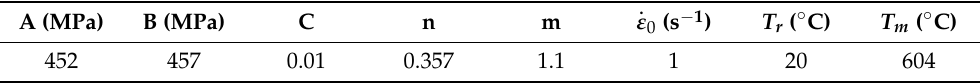
Table 3. Material constants for Al